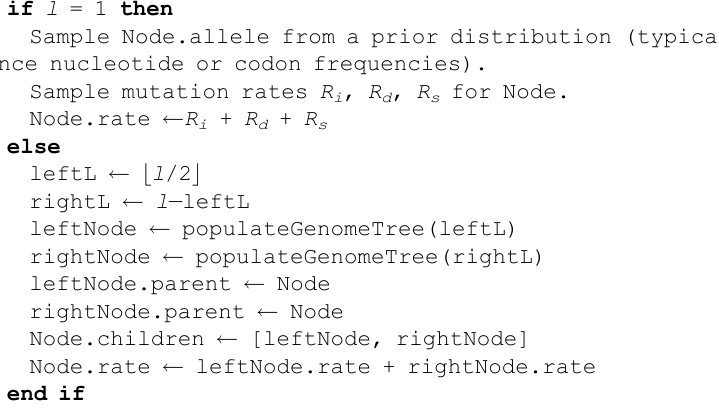
Algorithm 6 populateGenomeTree( l ): this function recursively creates a new genome sub-